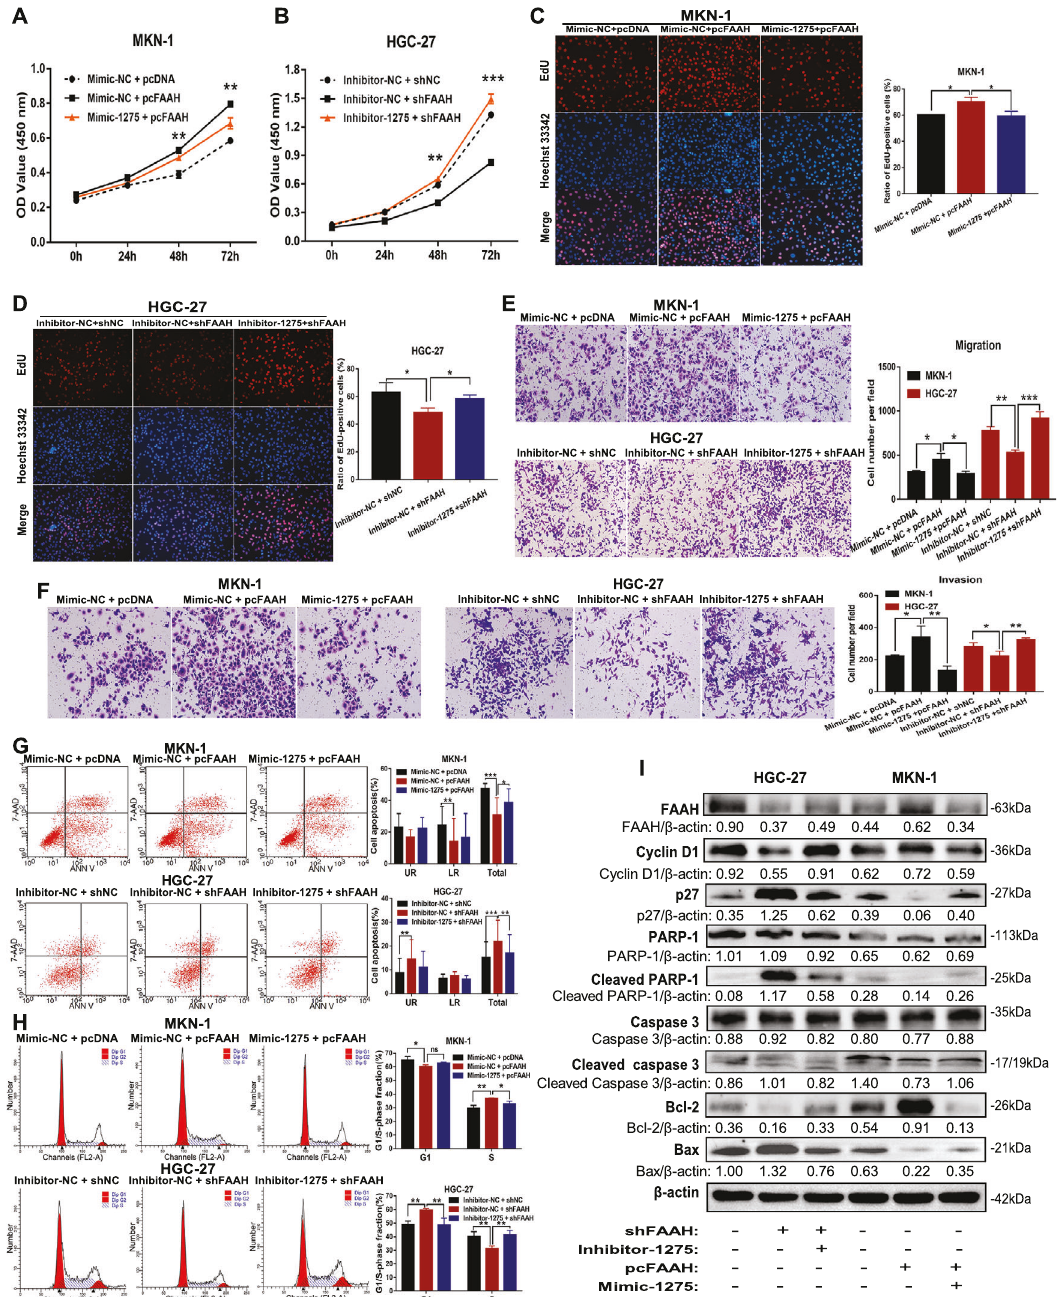
( E ) migration and ( F ) invasion after co-transfection of miR-1275 and FAAH in MKN-1 and HGC-27 cells. Changes of ( G ) cell apoptosis and ( H ) cycle progression after co-treatment with miR-1275 and FAAH plasmids were measured by fl ow cytometry. I Detection of apoptosis and cycle- related proteins by western blotting. * p < 0.05, ** p < 0.01, *** p <